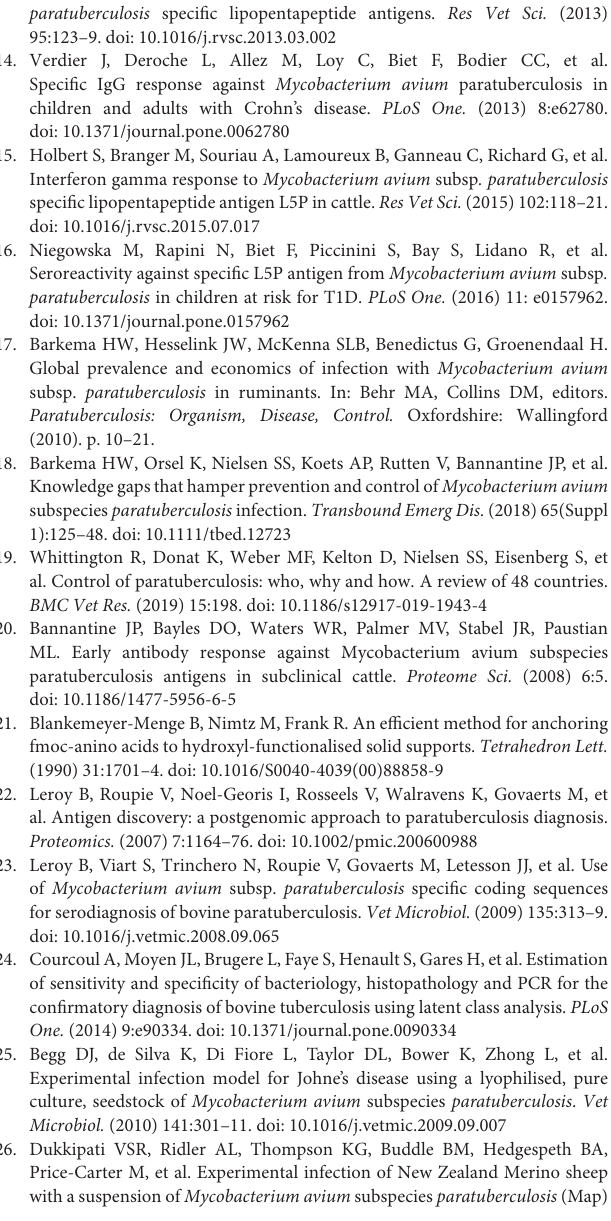
Supplementary Figure 1 | 1 H (A) and 13 C (B) NMR spectra of L5P-Aq. The corresponding structural formula is depicted in panel (C) . Supplementary Figure 2 | ROC analysis of antibody response of a bank of bovine sera in the IDEXX test. ROC analysis was performed on a bank of sera including 60 MAP positive and 50 control animals, using the commercial test IDEXX. All results are expressed as individual OD and were compared by ROC analysis. Serum samples were tested in triplicate. Significantly different when p < 0.05. ∗∗∗∗ p < 0.0001. The horizontal bars indicate median. Not significantly different (ns). Supplementary Figure 3 | ROC analysis of antibody response of the ovine serum panel in the IDEXX test. ROC analysis performed on a bank of sera including 39 MAP positive and 15 control animals, using the commercial test